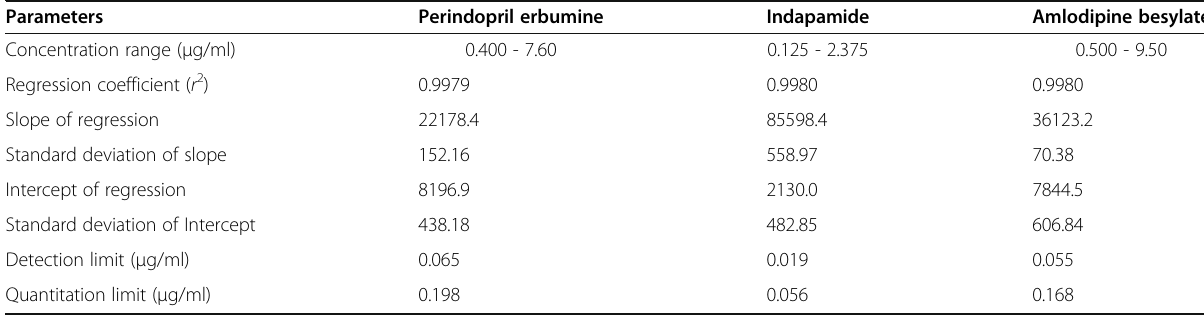
Table 1 Statistical data of calibration curve